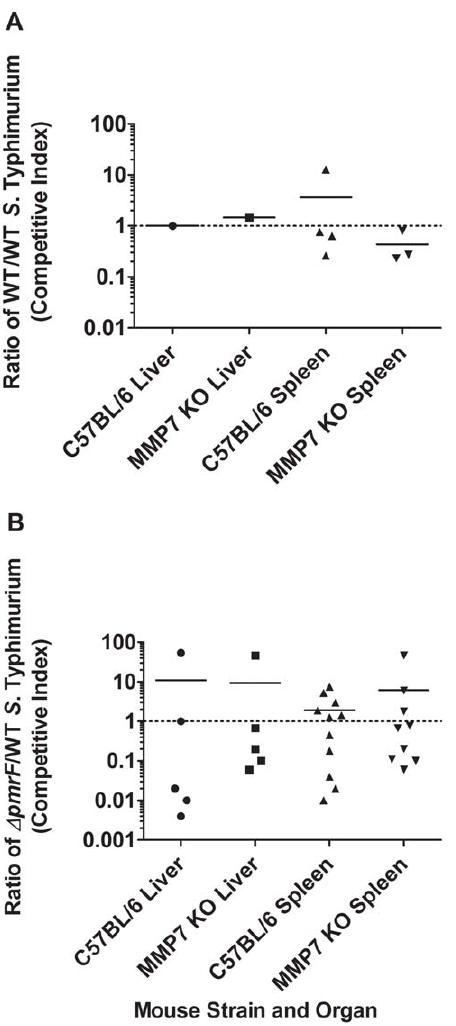
Figure 5. In vivo survival of WT and D pmrFS . Typhimurium in C57BL/6 and MMP7 KO mice. C57BL/6 (WT) and background- matched MMP7 (Matrilysin-deficient) mice were infected via the oral route with a 1:1 mixture of WT and WT S. Typhimurium, or WT and D pmrF S . Typhimurium containing 10 8 CFU of each strain. Graphed values represent the competitive index (CI) ratio output ratio/input ratio) of WT/WT (A.) or D pmrF/ WT (B.) recovered from the livers and spleens of MMP7 KO mice or C57BL/6 mice at 96 hrs. p.i. Each value graphed as the same shape represents the CI ratio calculated from the specified organ of one WT or MMP7 KO mouse. There are no significant differences between any of the observed average CI ratios (p $ 0.05).